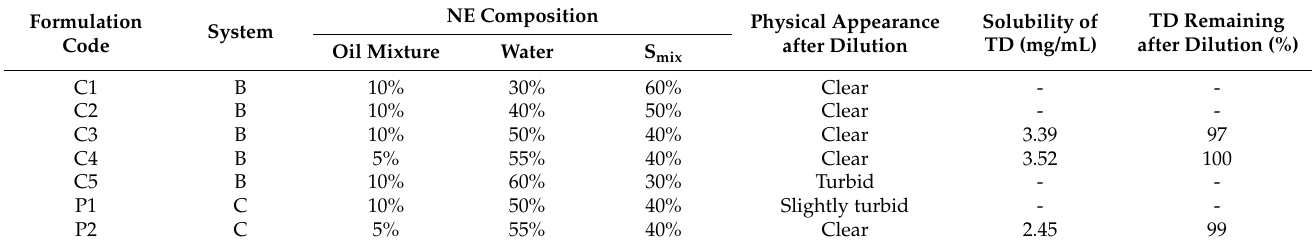
Table 2. Composition of the selected NEs and the corresponding formulation assessment concerning physical appearance after dilution, TD solubility, and drug remaining after